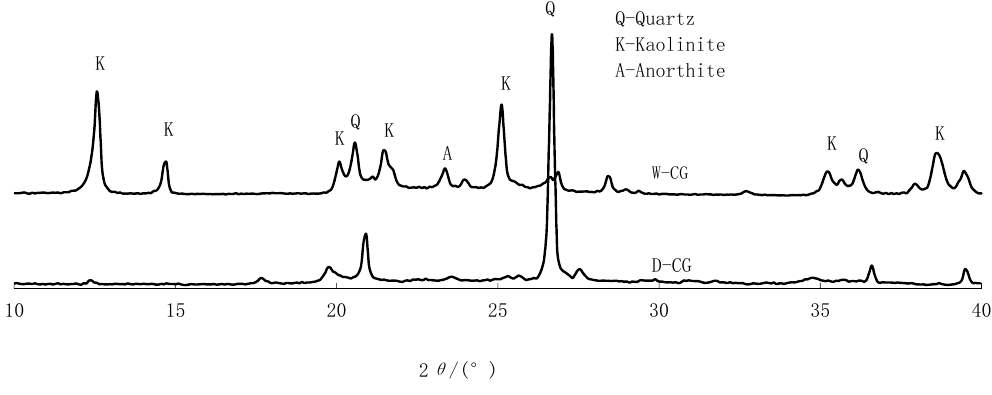
Figure 1. Mineral composition of coal gangues (CGs).